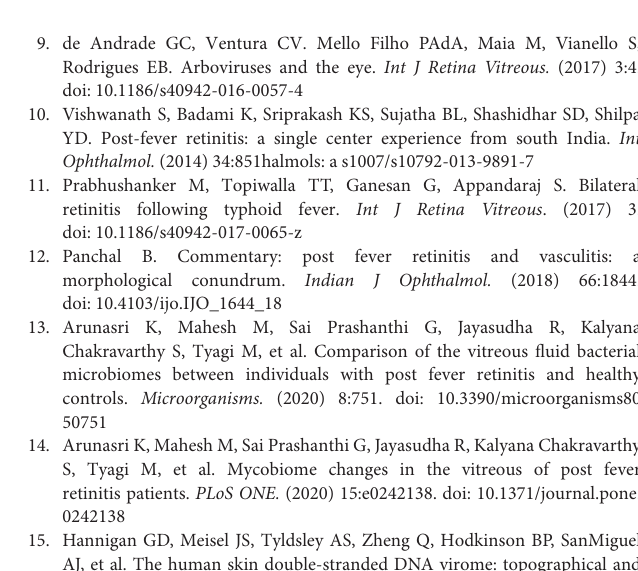
Supplementary Figure 1 | Non-metric multidimensional scaling (NMDS) analysis of the controls (VC), post-fever retinitis (PFR), and non-post fever retinitis (RET) groups. Three-dimensional NMDS are based on Bray-Curtis distances of (A) eukaryotic viruses and (B) bacteriophages. Supplementary Figure 2 | Rarefaction curves of the viromes generated for the 25 vitreous samples collected from healthy controls (VC) and individuals with PFR. Supplementary Figure 3 | STRING network analysis depicting Kyoto Encyclopedia of Genes and Genomes (KEGG) pathways. The colors of the nodes indicate the interaction of the proteins in specific pathways. Edges indicate co-expression evidence. The thickness of the edge indicates the strength of available data support. Inter-cluster edges are represented as dashed lines. Supplementary Figure 4 | Correlation Network (CoNet) analysis of discriminative viral genera in (A) VC group and (B) PFR group. Nodes represent the genera, red color edges indicate negative interaction, and green color edges indicate positive interaction. Supplementary Table 1 | Demographic file comprising the details of control samples (VC, n = 16) and post-fever retinitis samples (PFR, n = 9). Supplementary Table 2 | Virome Biome file of control (VC) and post-fever retinitis (PFR) samples. Supplementary Table 3 | Relative abundance of different viral groups in the vitreous of Control (VC, n = 15) and post-fever retinitis (PFR, n = 9) groups. Supplementary Table 4 | Relative abundance of Viral families in the vitreous of Control (VC, n = 16) and post-fever retinitis (PFR, n = 9) groups. Supplementary Table 5 | KEGG pathways in VC and PFR groups ( p <